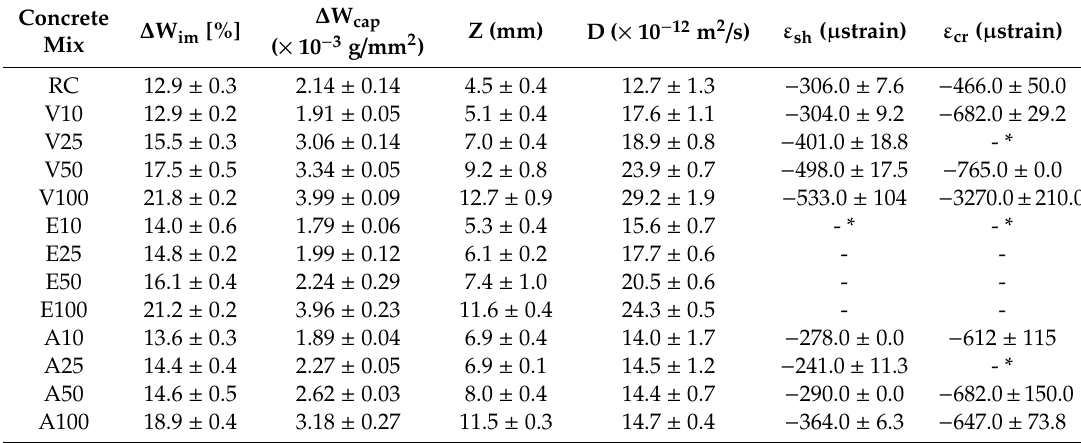
Table 2. Durability-related and long-term physical properties of the concrete mixes.